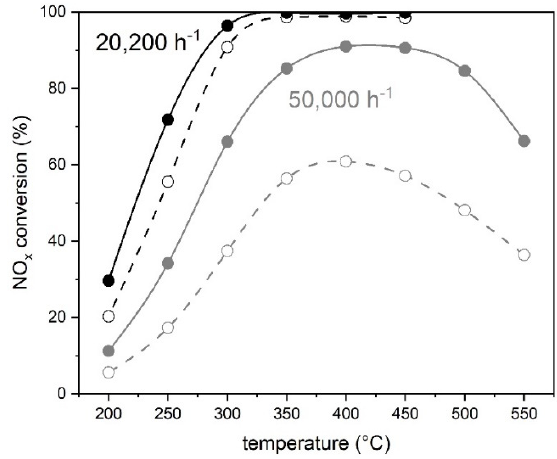
Figure 9. Maximum NO x conversion (solid lines) and NO x conversion at 10 ppm NH 3 slip (dashed lines) of sample 3D printed at GHSV = 50,000 h − 1 and GHSV = 22,200 h − 1 .